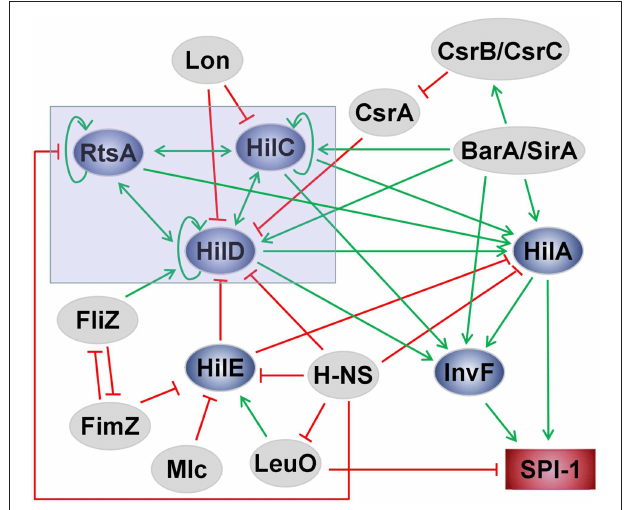
FIGURE 2 | Scheme of the SPI-1 regulatory network in Salmonella . The green arrows indicate activation, and the red lines with flat ends represent inhibition.